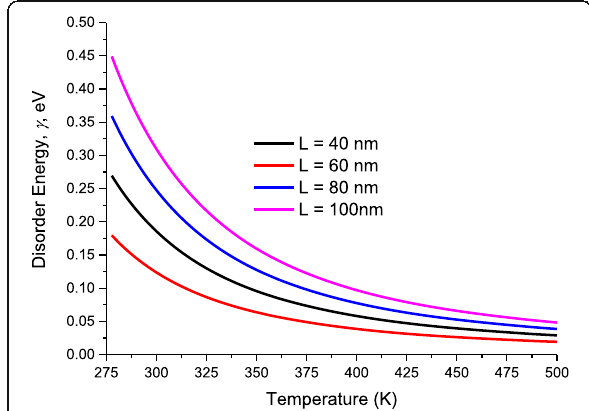
Fig. 5 The saturation current estimated after the fitting processes of experimental data in Fig. 4 to Eqs. (5, 6, and 7)